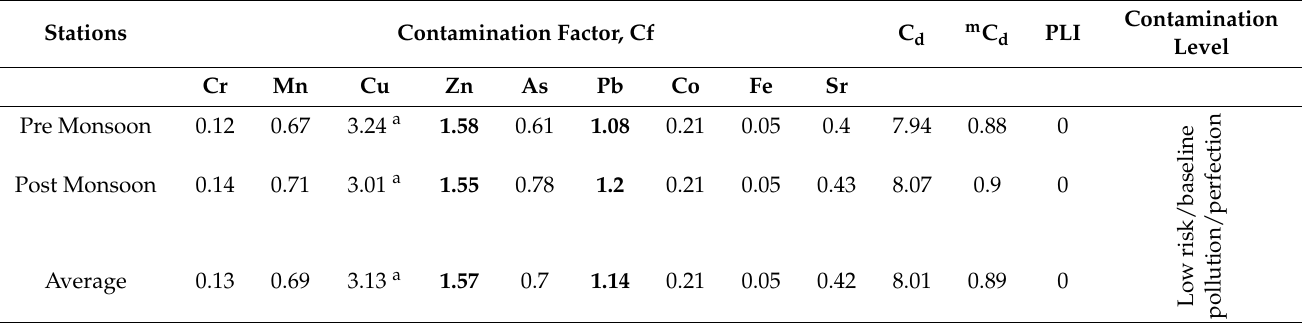
Table 4. The seasonal variation of C d , m C d , and PLI based on elemental concentration in sediment, Kutubdia Channel. Stations